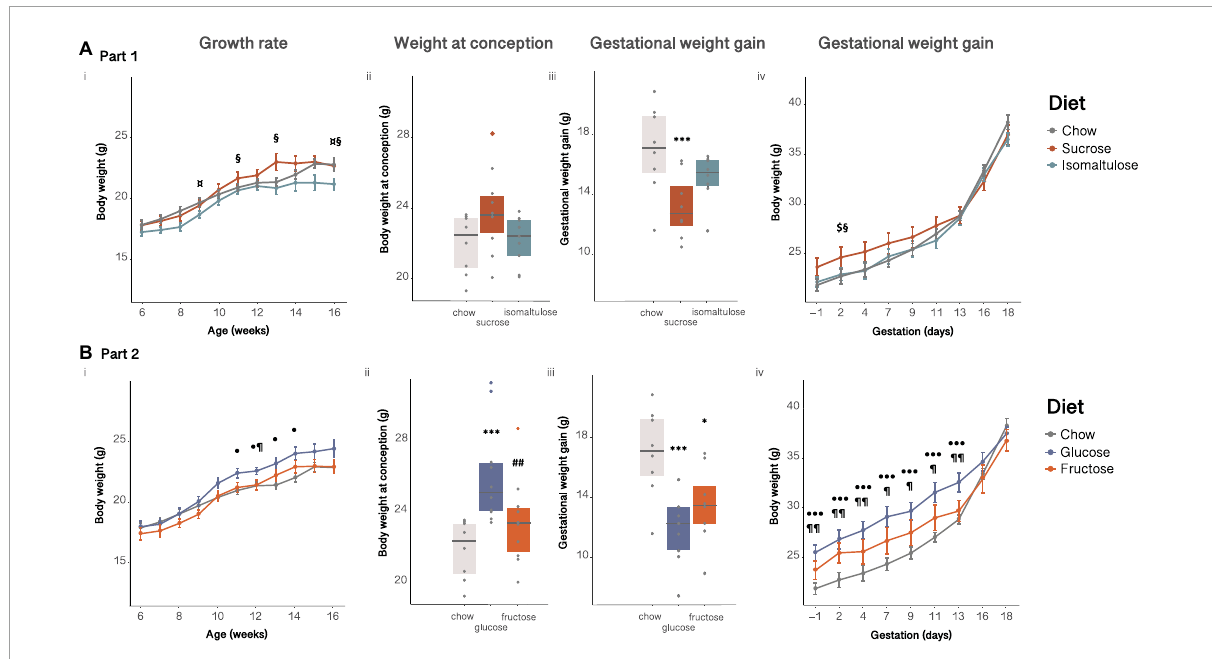
FIGURE1 Dam body weight (A) in Part 1 and (B) in Part 2: (i) pre-pregnancy, (ii) at conception, (iii) gained during pregnancy, (iv) during pregnancy. n = 8–10 per diet. Line graphs depict data as mean ± SEM. * p < 0.05 vs. chow; *** p < 0.001 vs. chow; ## p < 0.01 vs. glucose; $ p < 0.05 sucrose vs. chow; p < 0.05 isomaltulose vs. chow; p < 0.05 sucrose vs. isomaltulose; · p < 0.05 glucose vs. chow; ··· p < 0.001 glucose vs. chow; p < 0.05 glucose vs. fructose; p < 0.01 glucose vs.